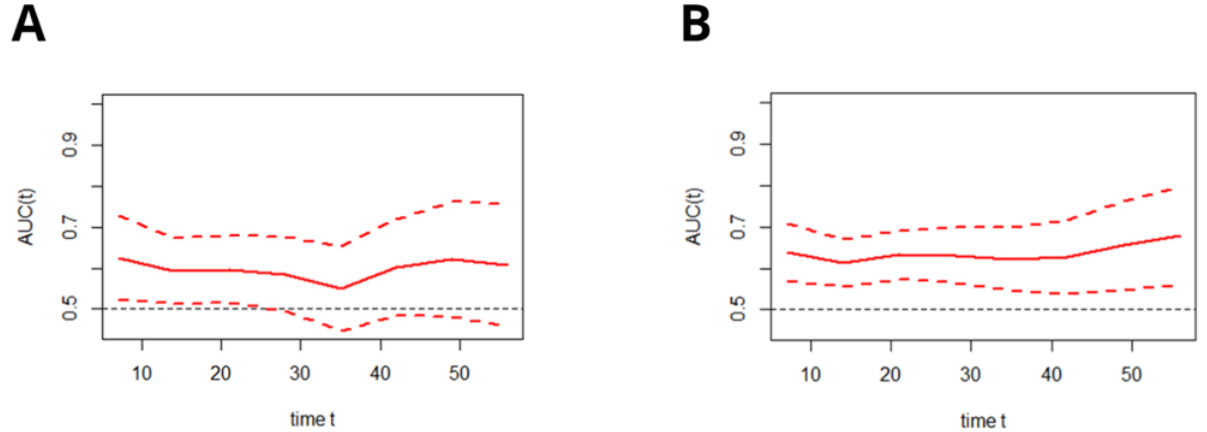
Figure 3. Time-dependent ROC analysis for the C 2 HEST predictive abilities of death during hospi- talization in the diabetic ( A ) and non-diabetic ( B ) cohorts (mean with CI). AUC—area under curve.